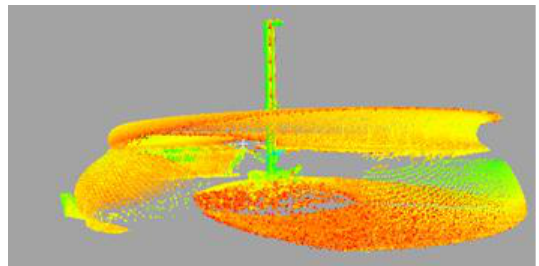
Figure 17. Three-dimensional laser scan after refraction correction for Trial 4 [36] (used with permission).